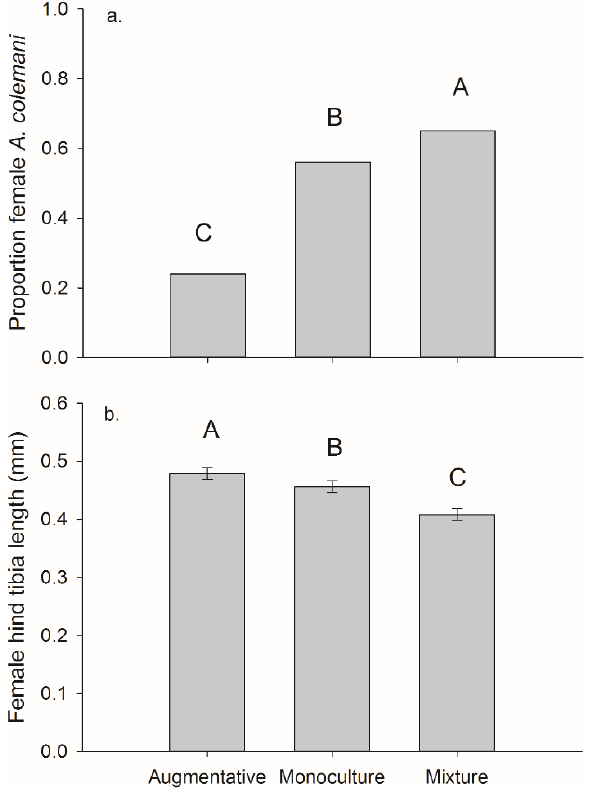
Figure 8. Mean (±SEM) ( a ) proportion of A. colemani that were female and ( b ) female hind tibia length of wasps reared from M. persicae on pepper plants in cages with augmentative release of A. colemani , monoculture banker plants, or mixture banker